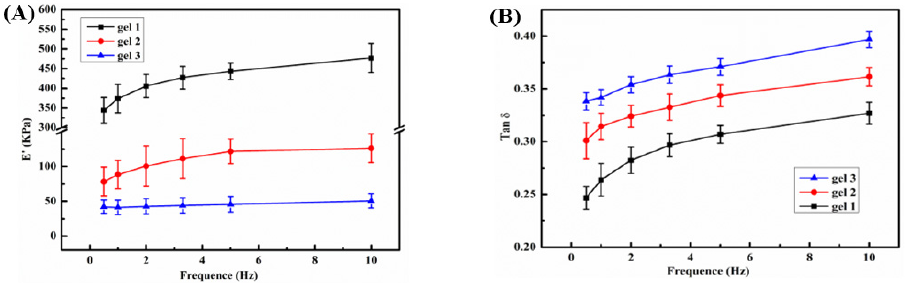
Figure 4. Variation curves of E’ ( A ) and tan δ ( B ) of hydrogels with frequency.